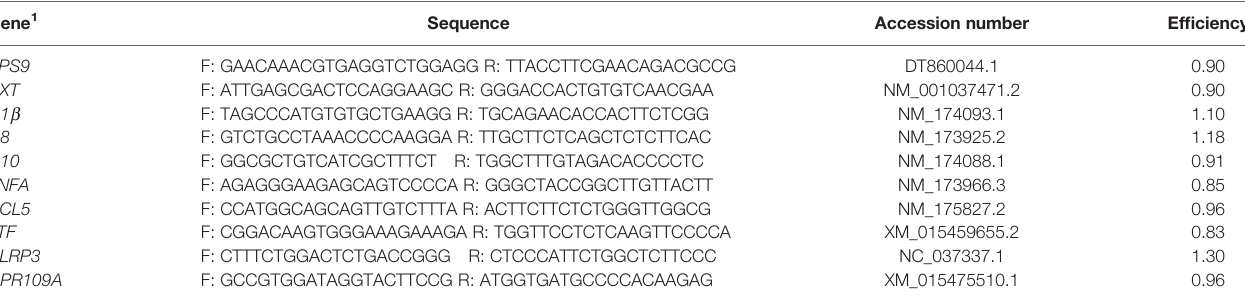
TABLE 1 | Sequence, accession number, and primer ef fi ciency for analyzed transcripts. Gene